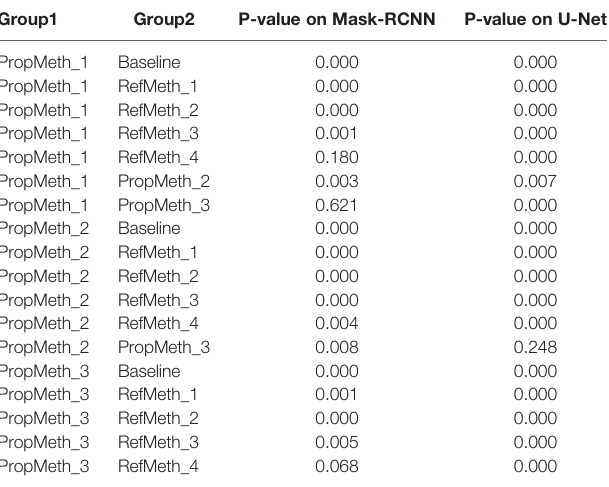
TABLE 5 | Results of statistical signi fi cance of